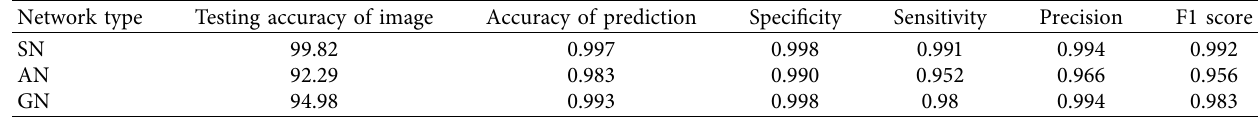
Figure 18: Fault classified by GoogleNet with testing accuracy. Table 5: Comparative measures of SN, GN, and AN.